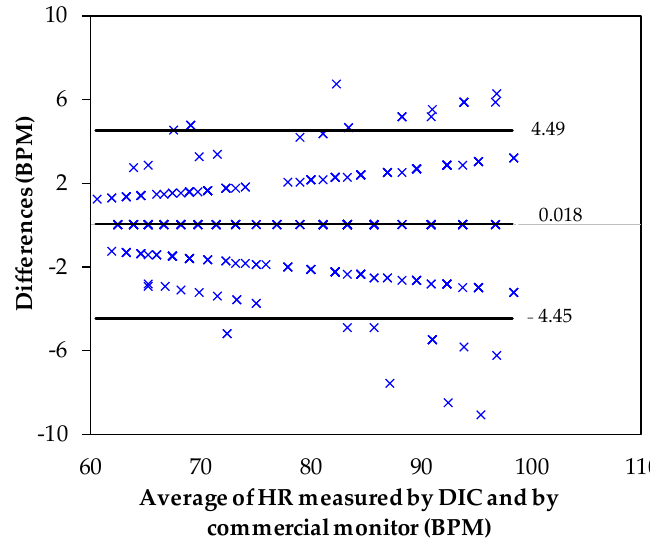
Figure 8. Bland–Altman plot that compares the HR measured by DIC and by the commercial monitor Figure 8. Bland – Altman plot that compares the HR measured by DIC and by the commercial mon- peak to itor peak to peak.